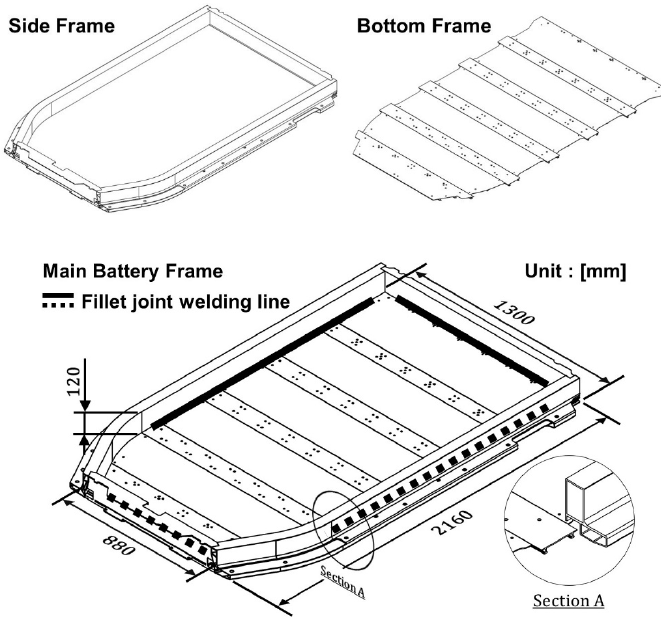
Figure 4. Full schematic diagram of fillet joint FSW for main battery frame.